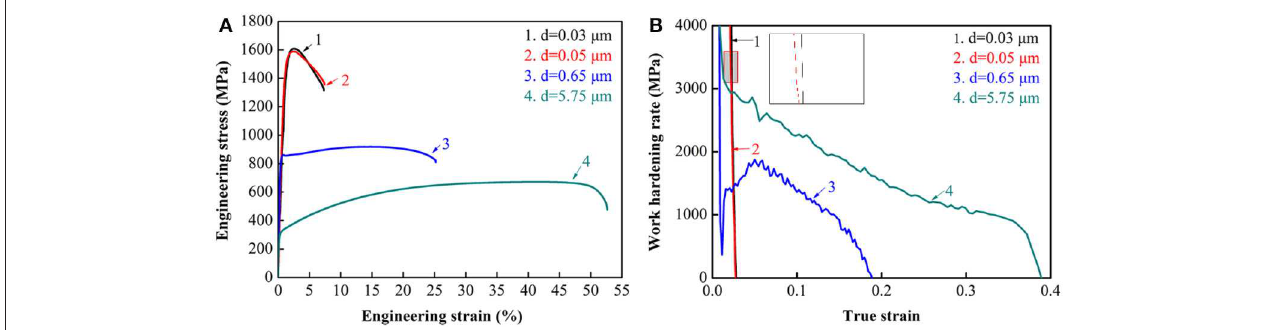
FIGURE 5 | Engineering stress–strain curves and corresponding work hardening curves of samples with different grain sizes at RT. (A) Engineering stress–strain curves and (B) work hardening curves.